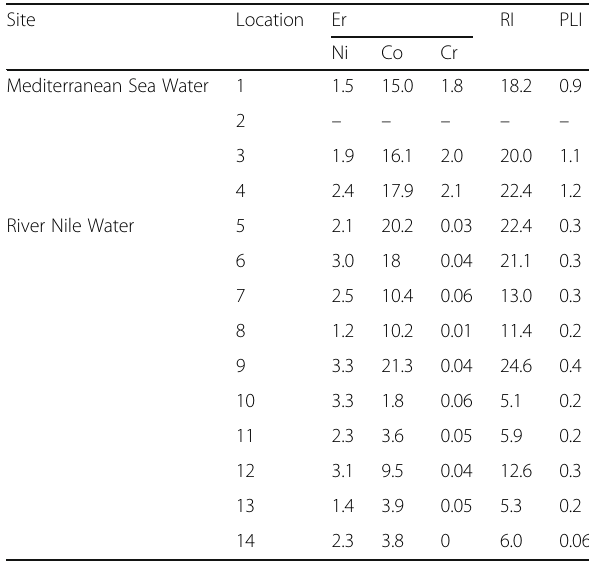
Table 3 Ecological Risk (Er), Risk Index (RI) and Pollution Load Index (PLI) in the sediment of freshwater and marine environments Site Location Er RI PLI Ni Co Cr Mediterranean Sea Water